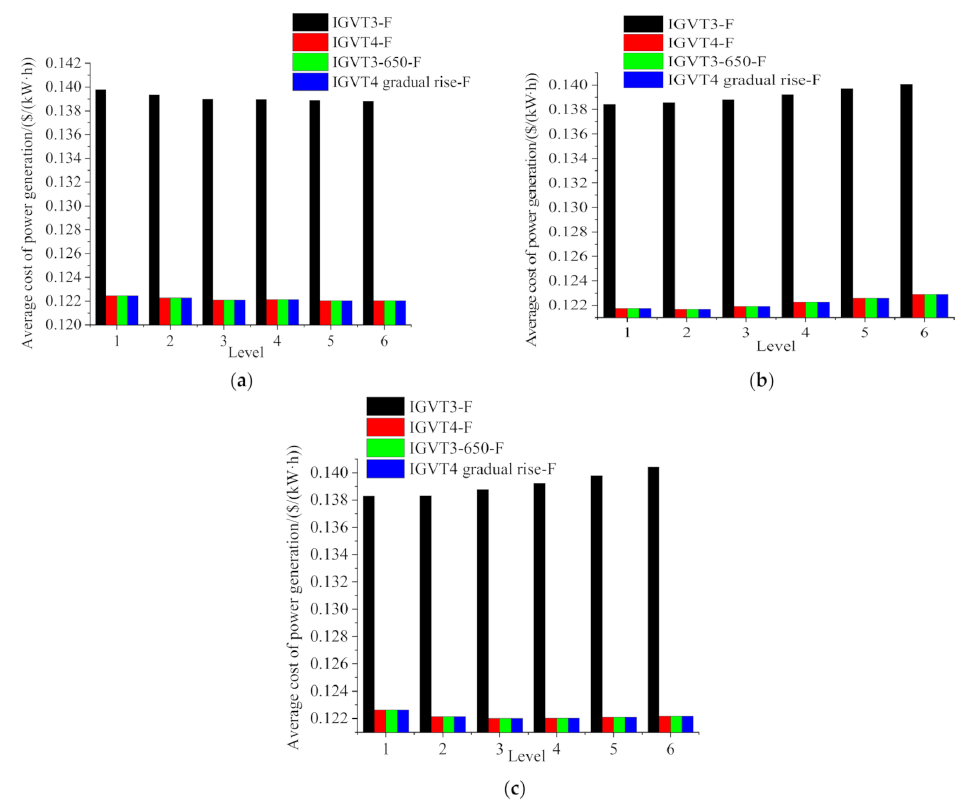
Figure 8. The average power generation cost under all levels (GT 25% load rate). ( a ) LP ( b ) IP ( c )